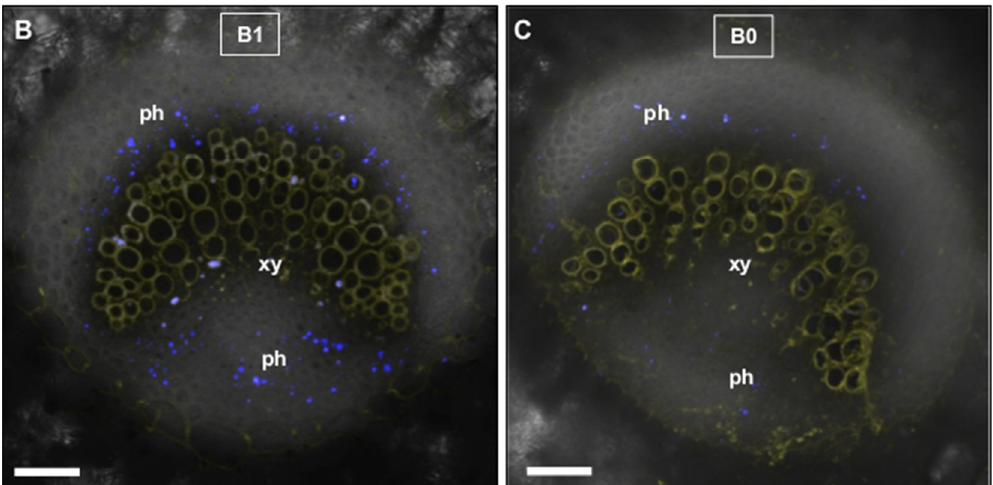
Figure 3. Distribution of esculin in the phloem of P. major grown under different soil B conditions. ( A ) schematic representation of the experimental set-up. ( B,C ) Representative cross-sections of vascular bundles from petioles. Yellow fluorescence indicates lignified xylem structures, and blue spots represent esculin-derived fluorescence in the phloem 3 h after loading of 100 mM esculin solution onto the adaxial side of source leaves of P. major plants grown under normal ( B ) (= B1 = 2.4 mg (kg soil substrate) −1 ) or low B ( C ) (= B0 = 0.1 mg B (kg soil substrate) −1 ) conditions. Source leaves of 10 plants per condition were treated with esculin and showed similar results. Abbreviations: ph = phloem, xy = xylem. Bars are 50 µm.